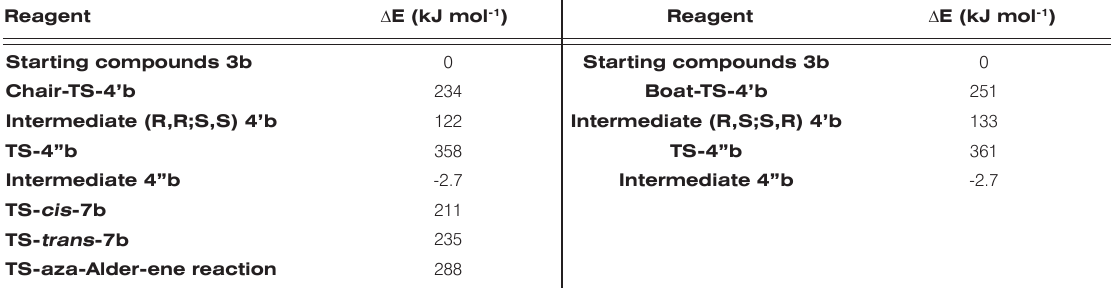
Table 1. Calculation on the formation of compound 7b